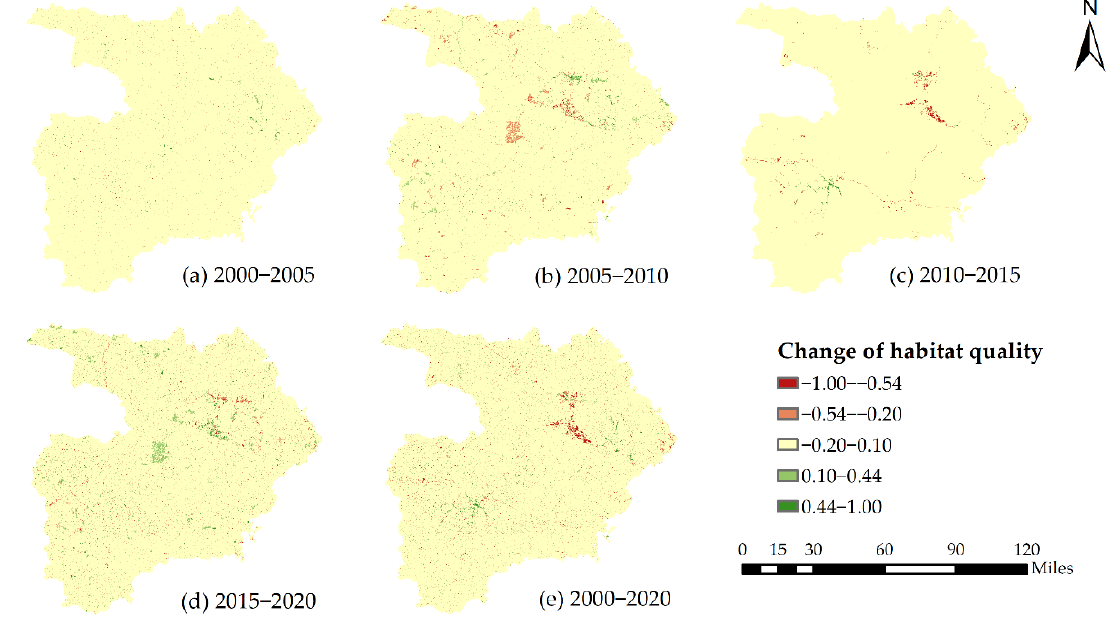
Figure 7. Spatial change of habitat quality in Shiyan from 2000 to 2020: ( a ) 2000–2005, ( b ) 2005–2010, ( c ) 2010–2015, ( d )